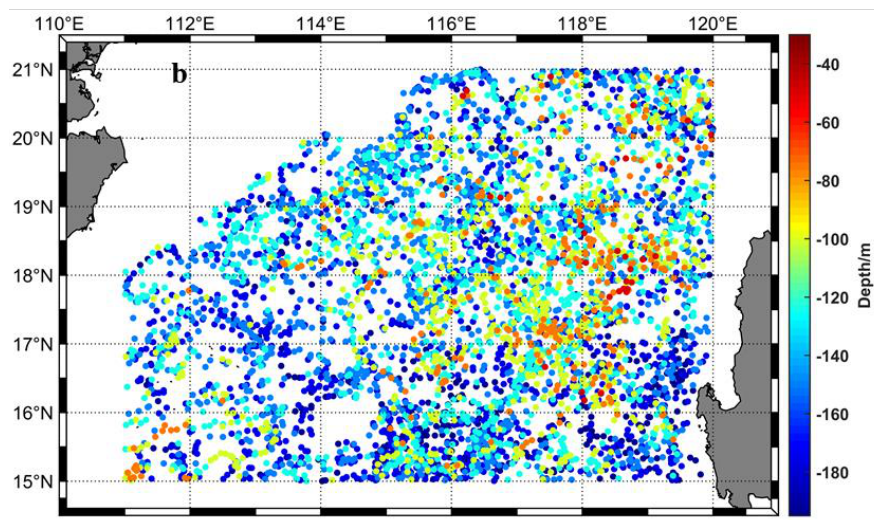
Figure 4. Scatter plots of ( a ) salinity in psu, and ( b ) depth in meters in the subsurface salinity-maximum layer from 2006 to 2019 in the NSCS.